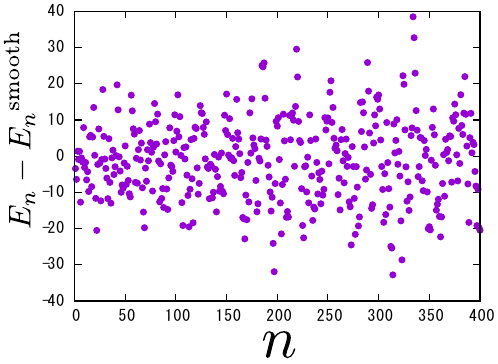
Figure 5 . Eigenvalues of the quantum stadium billiard with a/R =